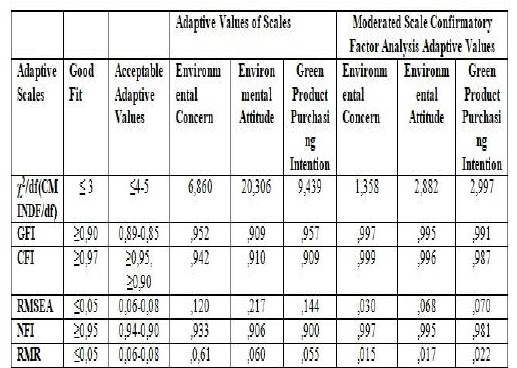
Table 4. Confirmatory Factor